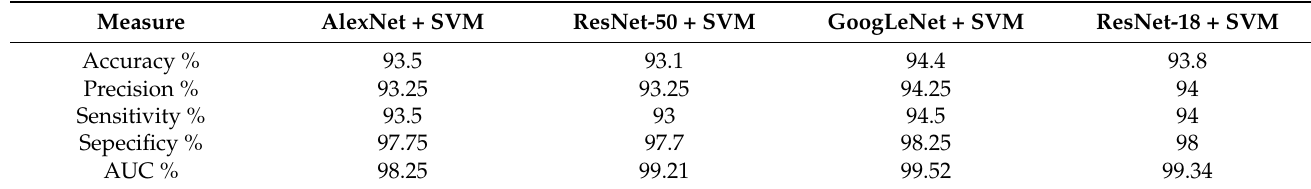
Table 5. The results of the CNN models used on the microscopic blood sample dataset.